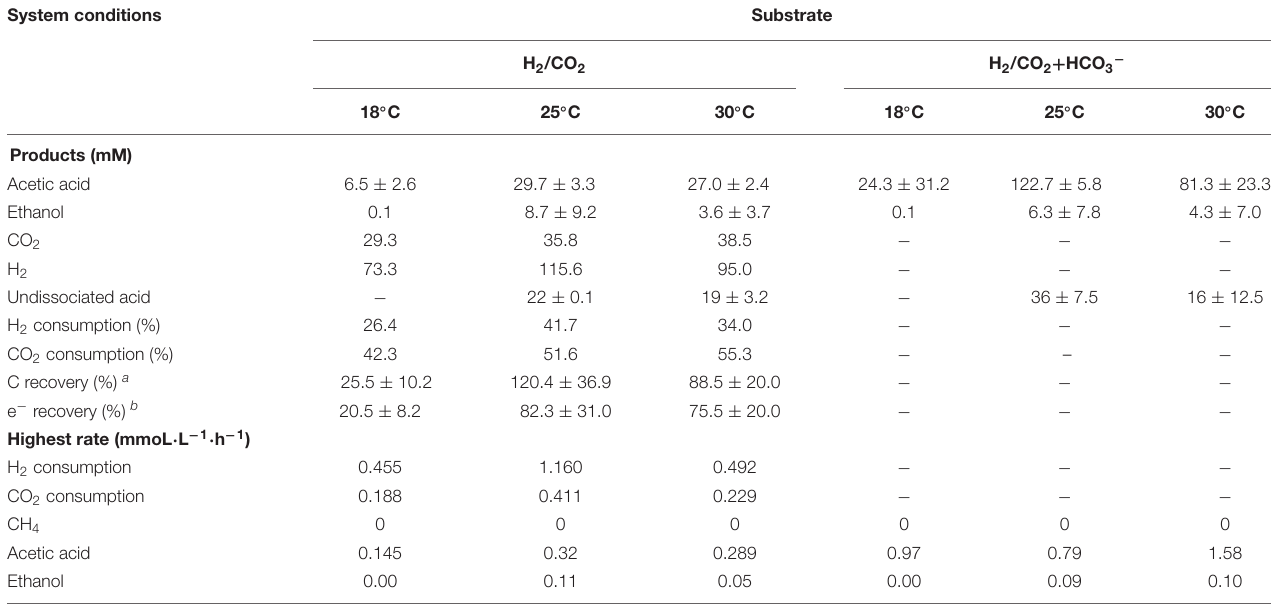
TABLE 2 | Effect of HCO 3 − on the maximum acetic acid and ethanol concentration from H 2 /CO 2 by heat-treated anaerobic granular sludge at initial pH 6. System